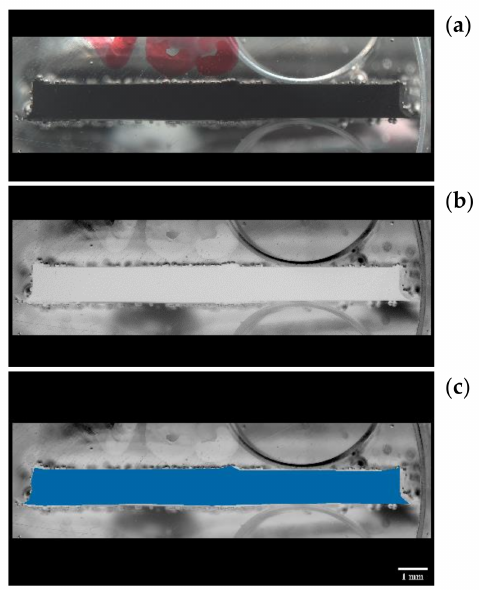
Figure 10. ( a ): initial image. ( b ): grayscale inverted image. ( c ): shaded RoI. Example of a cross-section of a strap used in our ImageJ